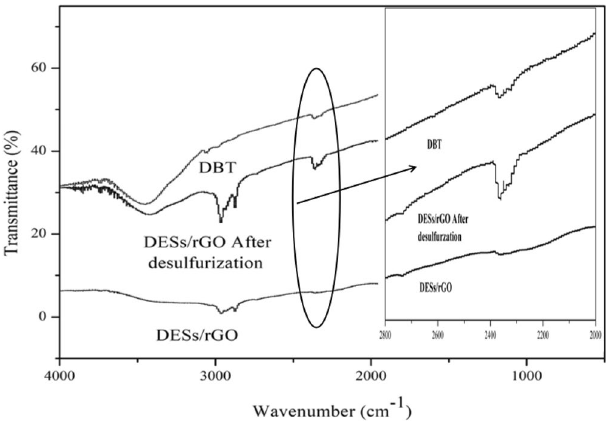
Figure 13. Infrared curve of DBT, DES/rGO, DES/rGO after